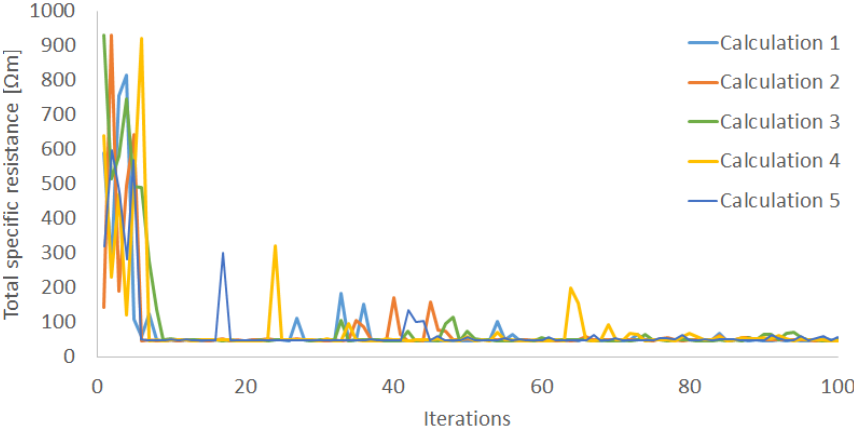
Figure 9. Convergence plot of five different initial conditions within 100 iterations. Table 5. Optimized process parameters for the total specific resistance.